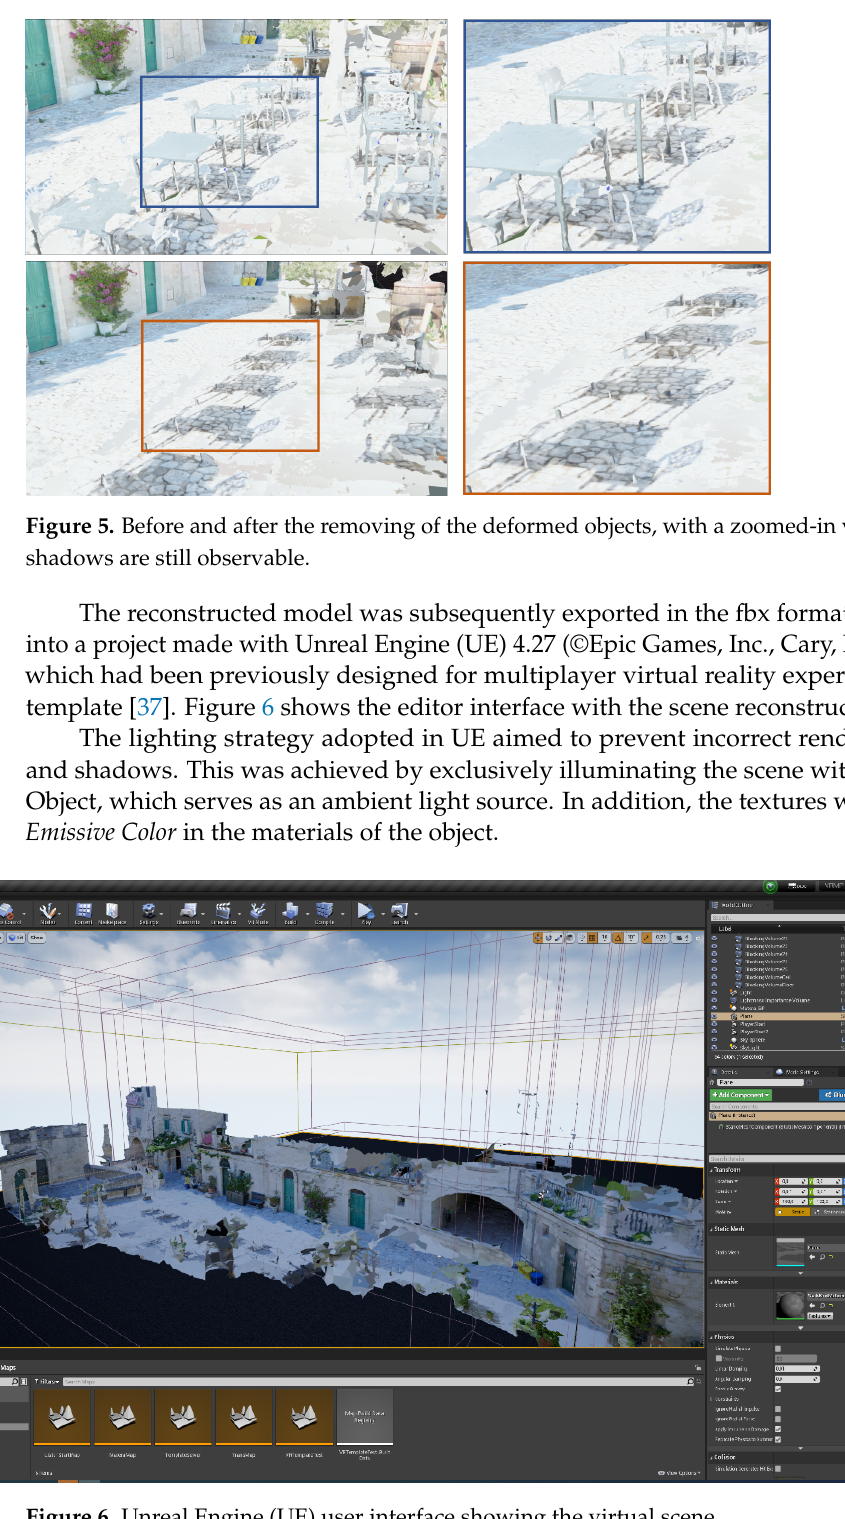
Figure 6. Unreal Engine (UE) user interface showing the virtual